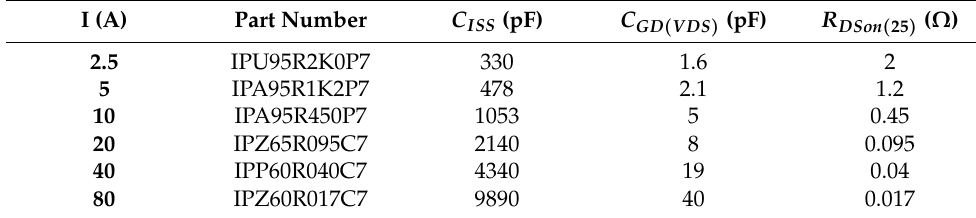
Table 3. Characteristics of selected SJ MOSFETs.